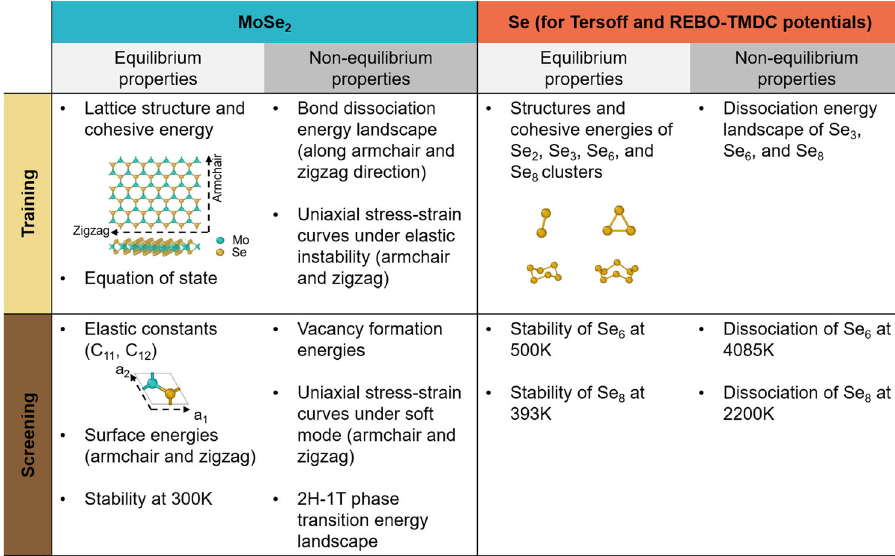
Fig. 2 Target properties of monolayer MoSe 2 and Se systems. The properties are segmented with regard to their regime (equilibrium versus nonequilibrium), as well as their purposes for the parametrization (training versus screening). Properties of MoSe 2 are used for all interatomic potentials, while properties of Se are only used for parameterizing single-element interactions of the Tersoff and REBO-TMDC potentials. Atomic illustrations show the structure of MoSe 2 and Se clusters.